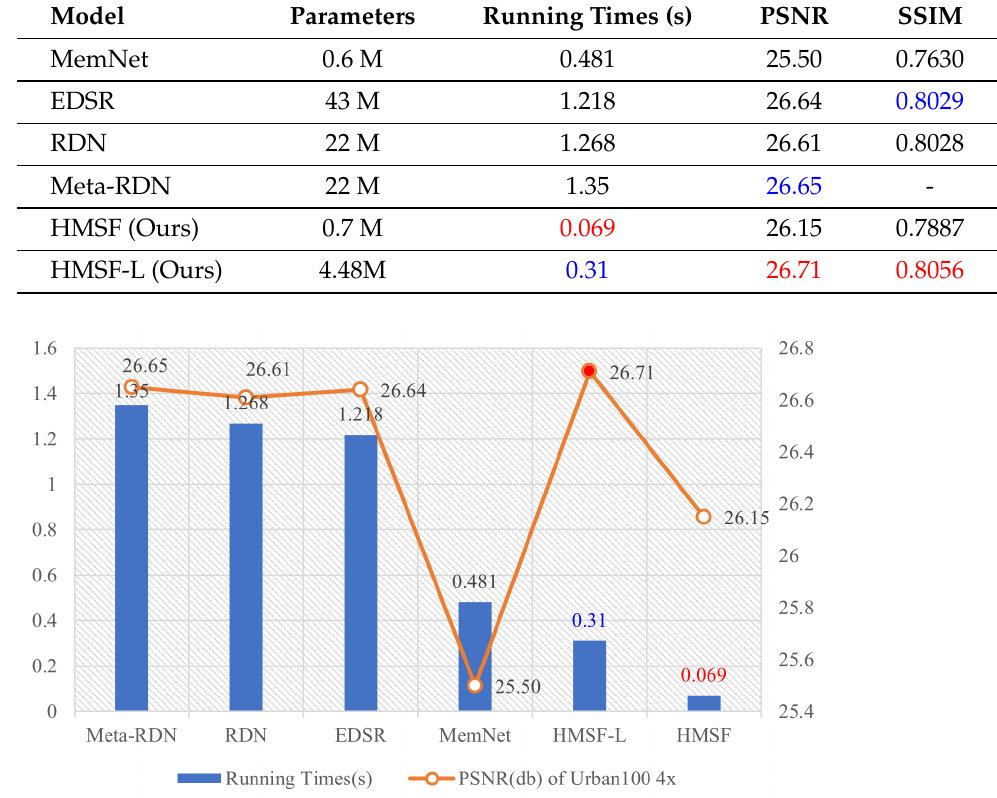
Figure 14. Diagram analysis of model running times and performance. The proposed model achieves the best performance with lower running